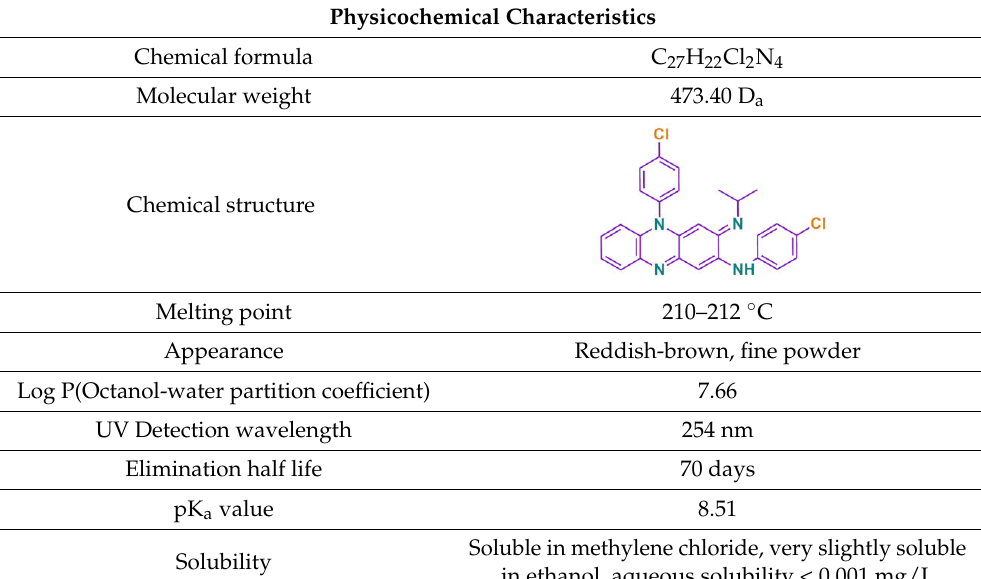
Table 2. Physicochemical Characteristics of Clofazimine a